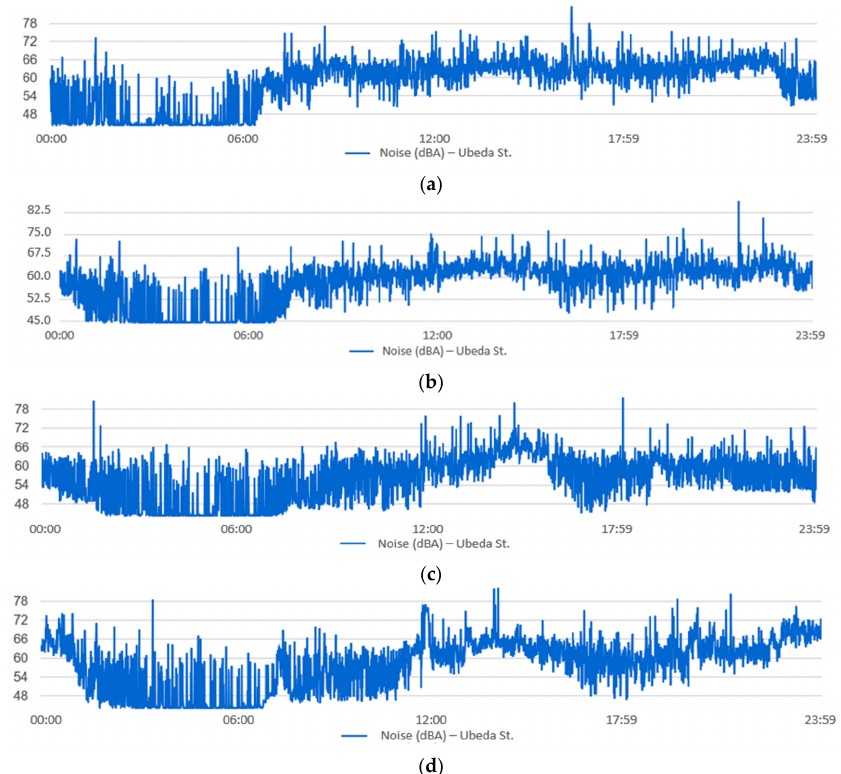
Figure A7. The temporal evolution of the noise in Ubeda Street during: ( a ) a weekday, 18 May 2017; ( b ) a weekday, 1 April 2016; ( c ) a weekend day, 3 May 2017; ( d ) a weekend day, 16 April 2017.